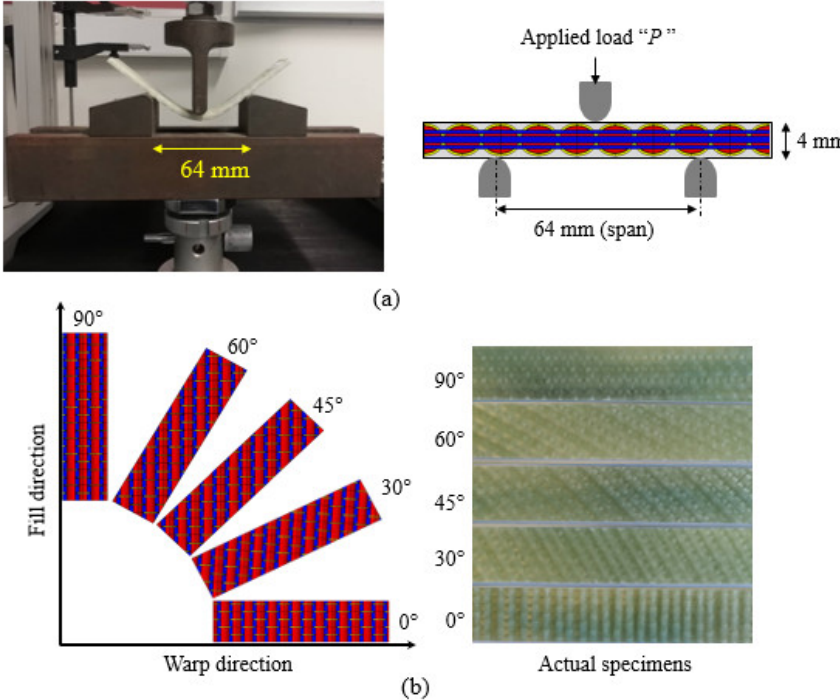
Figure 3. Samples prepared for the flexure testing of 3D-FRC: ( a ) 3D fabric architecture with different fibre orientations and actual specimens cut into different orientations and ( b ) flexure testing setup and schematic diagram of three-point bend test.